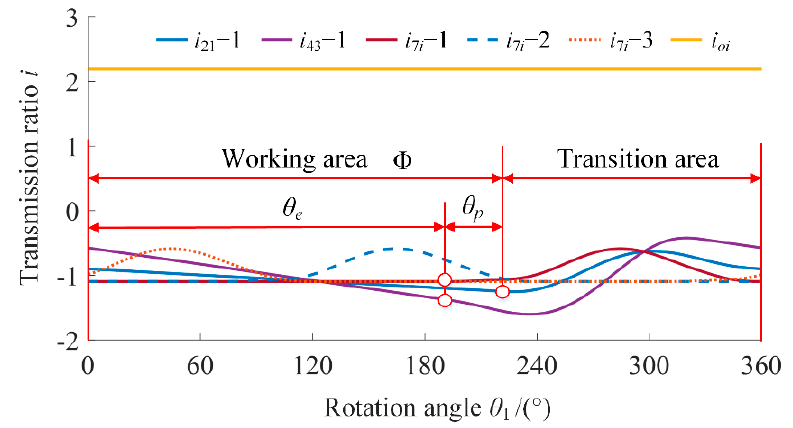
Figure 7. Transmission ratio variation law of class A.